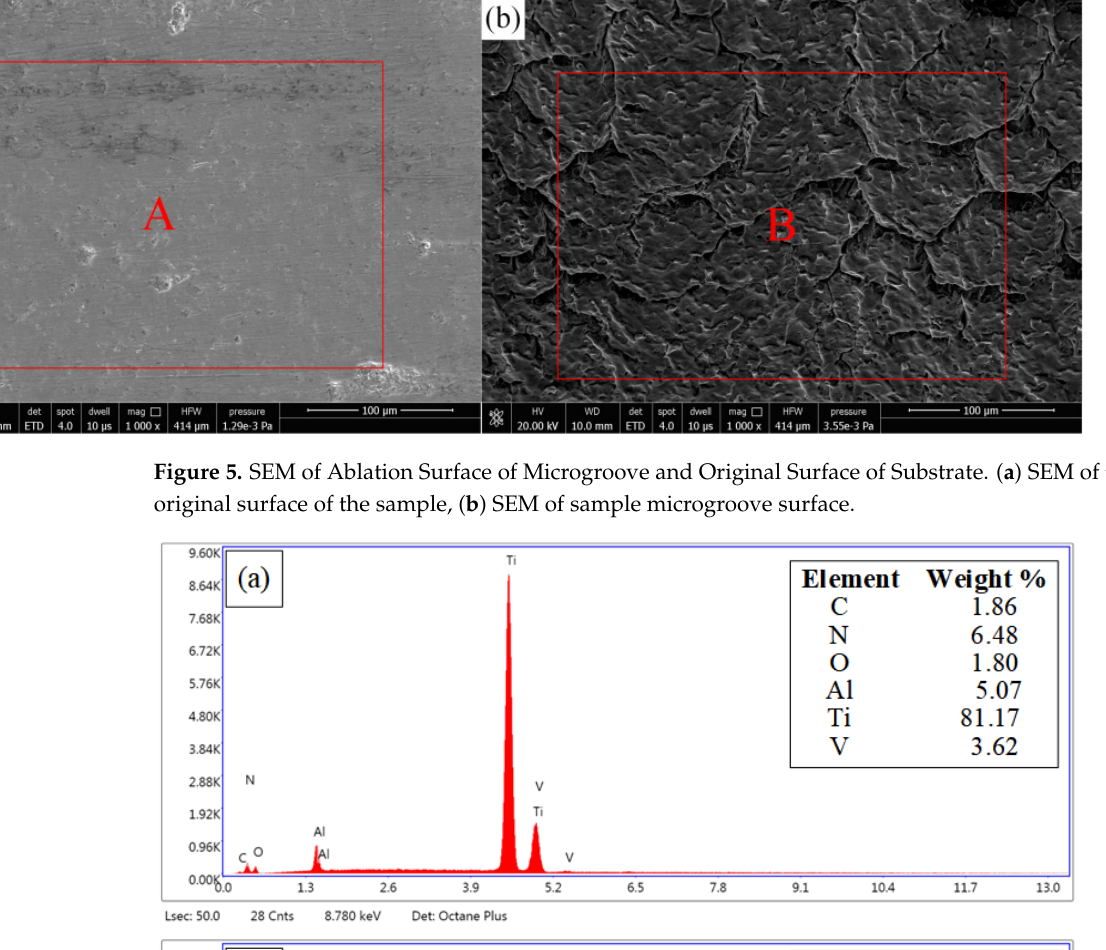
7 of 24 Figure 4. Schematic diagram of surface morphology of Ti-6Al-4V alloy microgroove. ( a ) Cross section of microgroove, ( b ) Three dimensional morphology of microgroove. The microgroove depth, microgroove top width, taper angle, and cross-sectional area can also be clearly seen from the figure. At the same time, it is found that there is no ob- vious heat-affected zone around the microgroove. The depth of the microgroove is about 109.275 µm, the top width of the microgroove is about 213.132 µm, and the taper angle is 47.7°. For waterjet-guided laser processing of the microgroove, it is expected to obtain a larger aspect ratio and material removal rate under the same waterjet-guided laser pro- cessing parameters. Therefore, the machinability evaluation indicators in this paper mainly include the depth of the microgroove, the top width of the microgroove, and the material removal rate. The material removal rate is calculated by dividing the workpiece mass loss by the processing time, which can be expressed as: b a M M MRR t − = (2) where M b is the quality of the workpiece before processing, M a is the quality of the work- piece after processing, and t is the processing time. Figure 5 is the micromorphology of the original substrate surface and the micro- groove ablation area obtained by the field emission scanning electron microscope (Apreo, FEI). Figure 6 shows the results of chemical composition content on the surface of the Ti- 6Al-4V alloy original substrate and microgroove ablation area using an X-ray energy dis- persive spectrometer (EDS) attached to an SEM. Figure 5a shows the original surface mor-